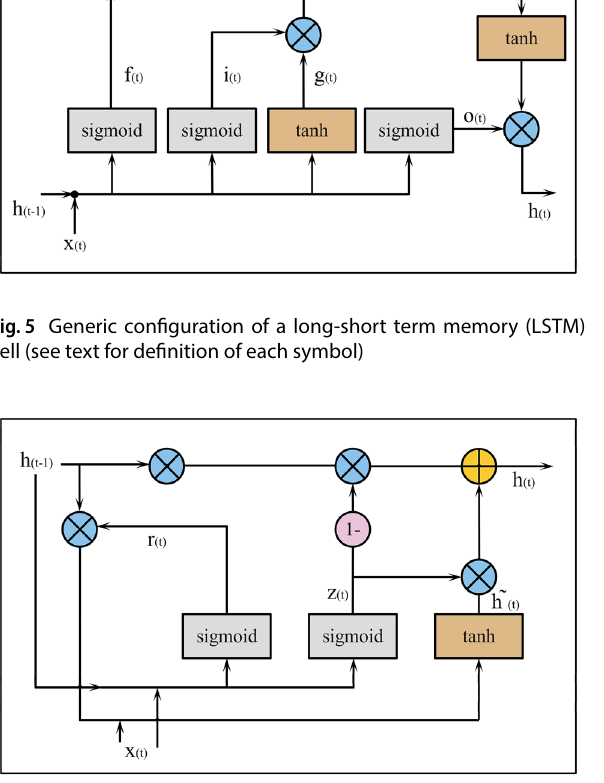
Fig. 6 Generic configuration of a gated recurrent unit (GRU) cell (see text for symbol